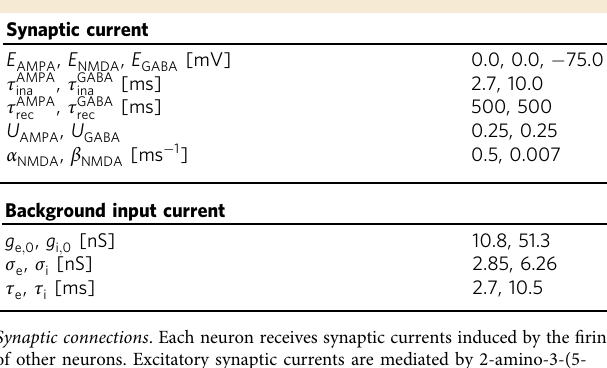
Table 3 Parameters for synaptic currents and